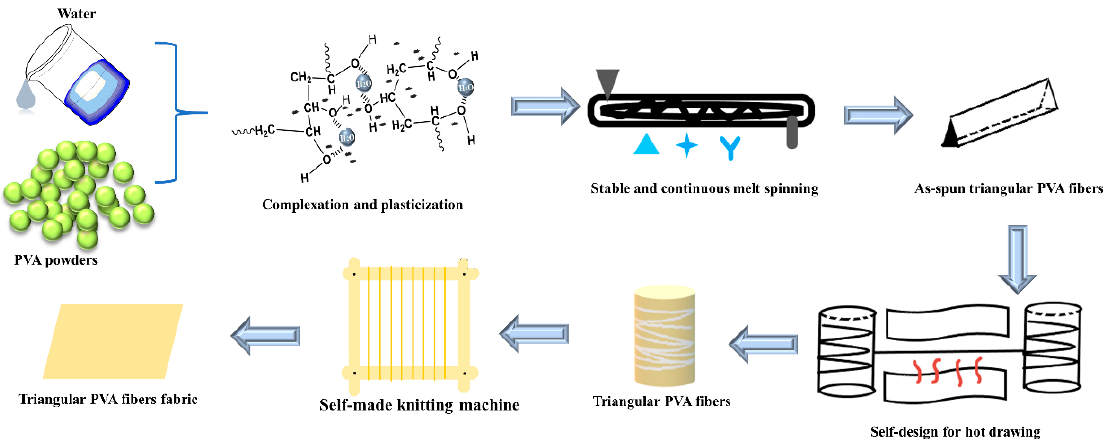
Figure 1. Preparation of triangular PVA fibers and fabric.